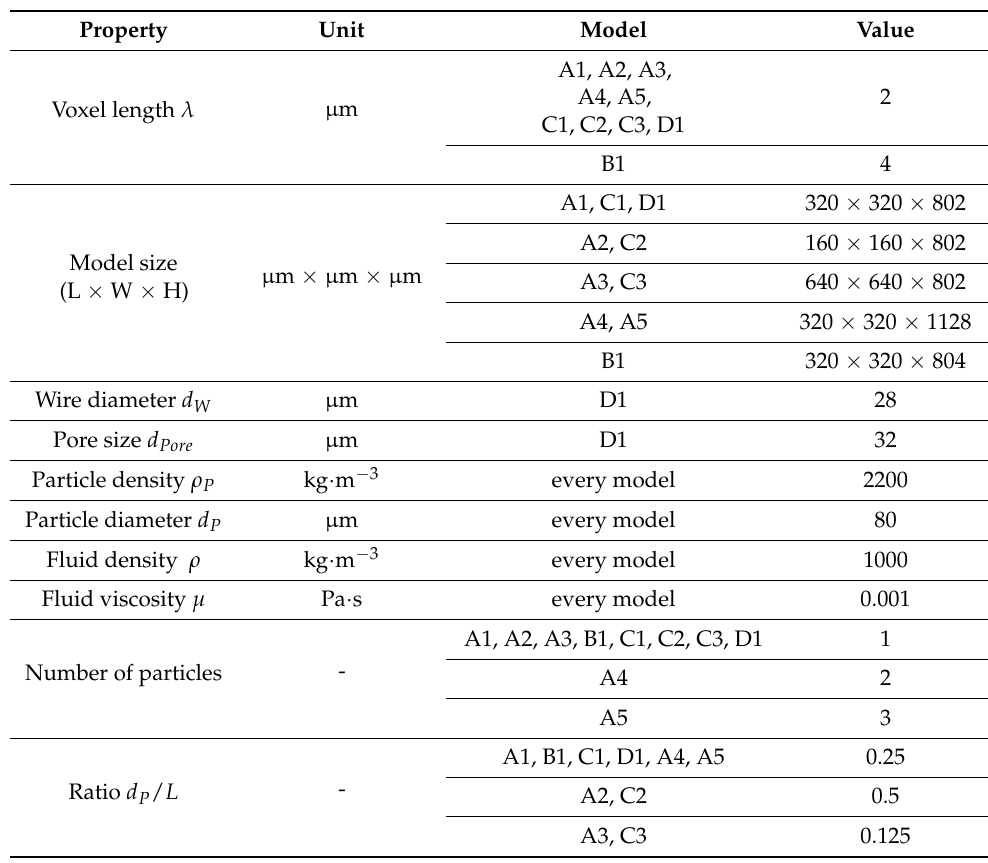
Table 2. Model parameters of the simulated cases.